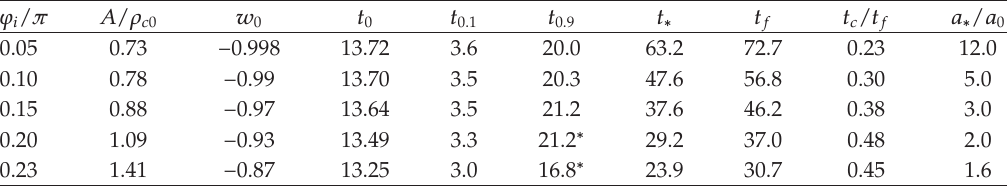
Table 1: Parameters for the potential V (cid:9) A cos (cid:2) ϕ (cid:3) . t 0 is the current age of the universe with t 0 ≡ 13 . 73Gyr in the Λ CDM model, 0 . 1 ≤ Ω DE ≤ 0 . 9 for t 0 . 1 ≤ t ≤ t 0 . 9 , the “coincidence” time interval Δ t c (cid:9) t 0 . 9 − t 0 . 1 , t ∗ is the turn-around time, t f is the time of the big crunch, and a ∗ (cid:9) a (cid:2) t ∗ (cid:3) . All times are in Gyr. ∗ For ϕ i /π